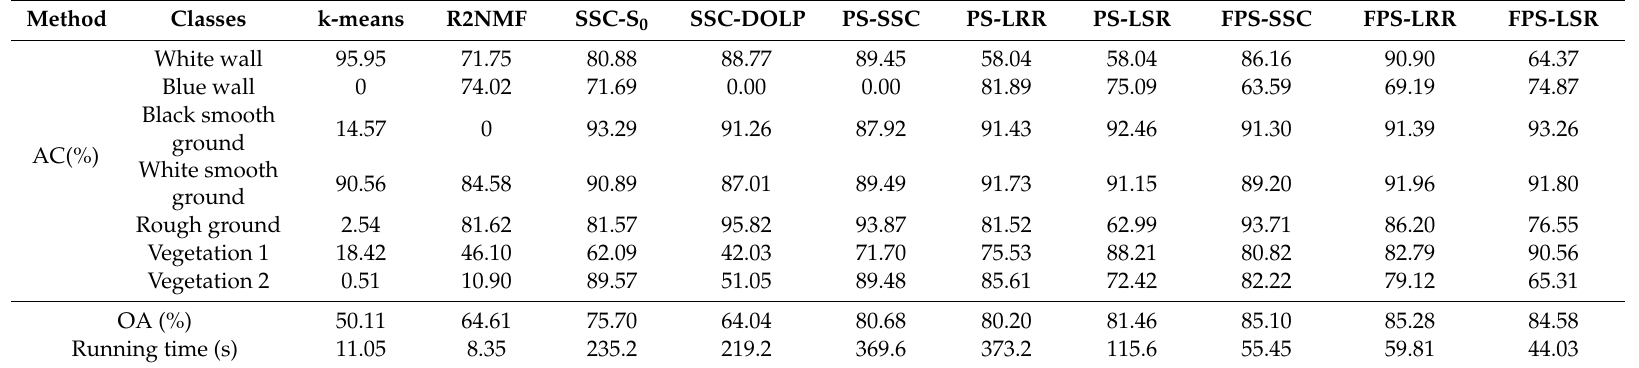
Table 3. Quantitative evaluation of the di ff erent clustering algorithms of dataset